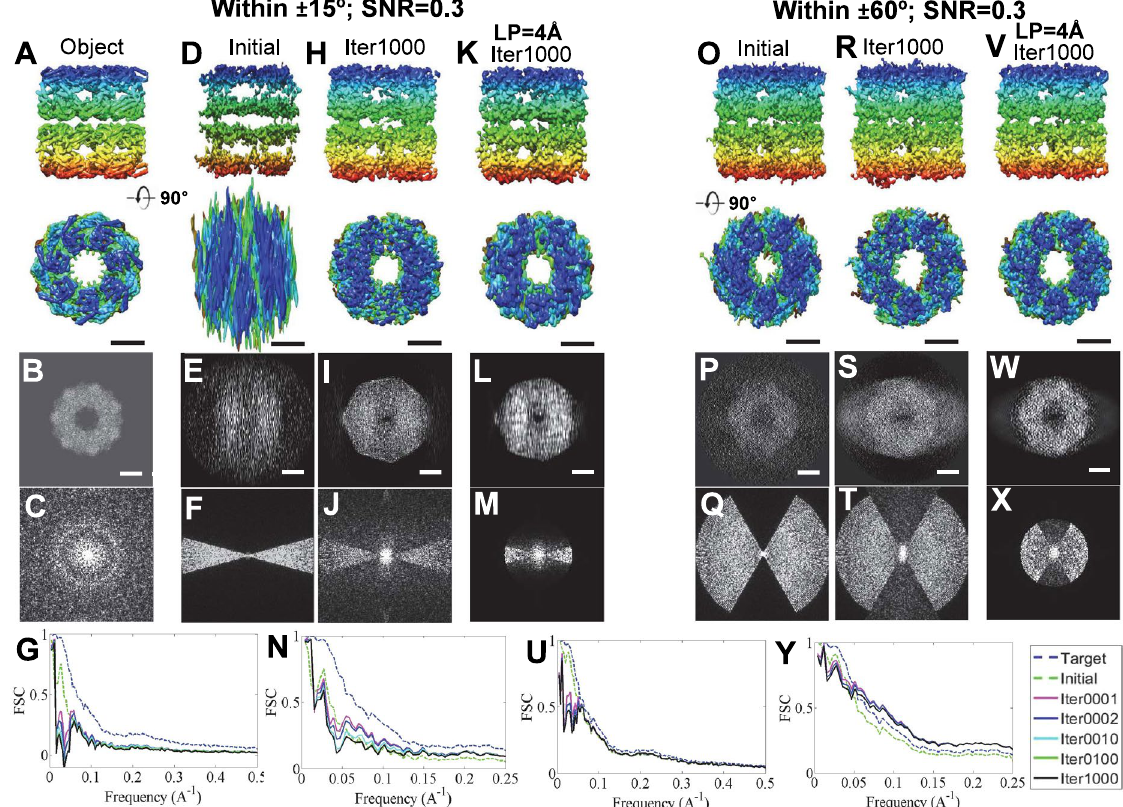
Figure 4. The missing-wedge correction on two simulated 3D maps of GroEL reconstructed from the noisy tilt series (SNR = 0.3) within the tilt angle range of ± 15° and ± 60°. ( A ) Two perpendicular views of the object of GroEL, ( B its projection on the X-Z plane and ( C ) the corresponding Fourier transform. ( D ) The initial 3D map, shown from two perpendicular views. The initial 3D map was constructed from a noisy tilt series (SNR = 0.3) in a range of ± 15° in steps of 1.5°, while the ideal 3D map was constructed from that of ± 90°. ( E ) The projection of the initial 3D map on the X-Z plane and ( F ) its Fourier transform. ( G ) The FSC curves of the initial, ideal and iterative 3D maps against the object. The iterative 3D maps were generated after 1, 2, 10, and 100 cycles of interaction of missing-wedge correction. ( H ) The final restored 3D map (after 1,000 iterations of missing- wedge correction), shown from two perpendicular views, ( I ) the corresponding 2D projection (along the X-Z plane) and ( J ) the Fourier transform. ( K ) To reduce the influence of noise, the noisy tilt series (SNR = 0.3) were filtered to 4 Å before generating an initial 3D map for restoration. The final restored 3D map after 1,000 iterations is shown from two perpendicular views, as well as the ( L ) 2D projection (along the X-Z plane) and ( M ) Fourier transform. ( N ) The FSC curves of the initial, ideal and iterative 3D maps against the object. ( O-Y ) The procedures were repeated by using the above tilt series for the angle range of ± 60°. All 3D maps were low- pass filtered to 8 Å. Scale bars: 50